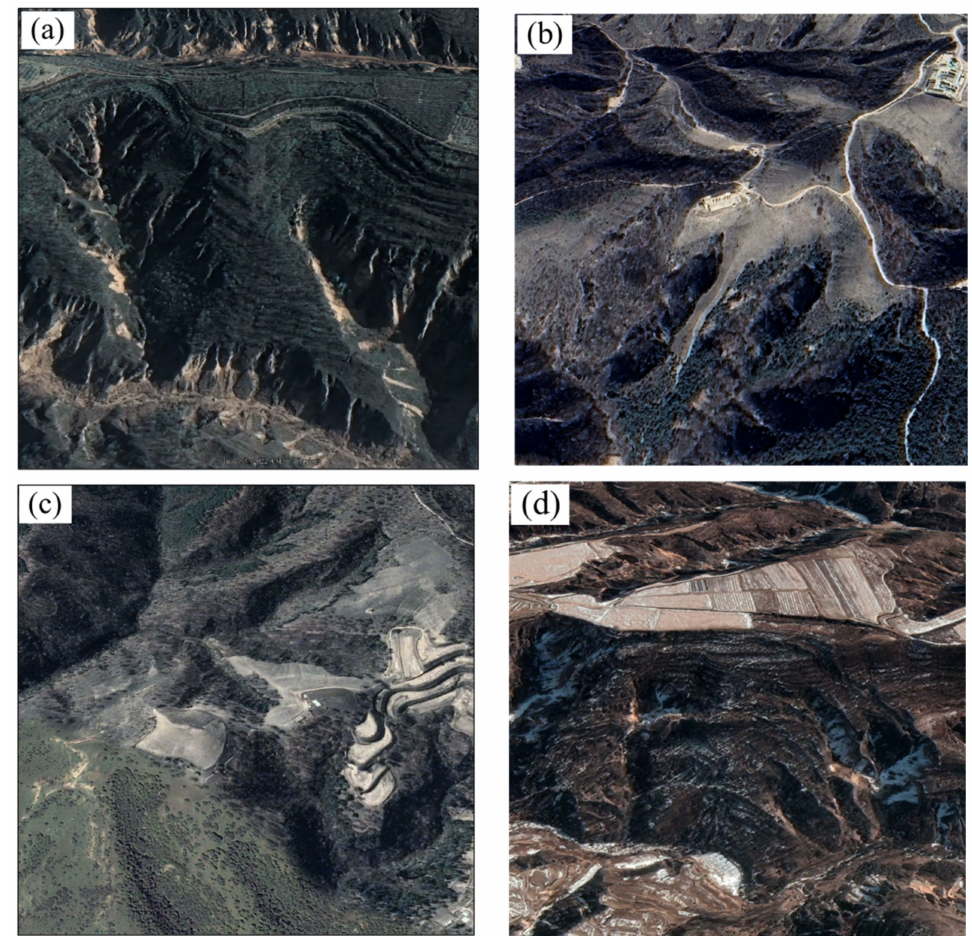
Figure 16. Examples of landforms in loess ridge and hill regions. ( a – d ) show the distribution of shoulder lines in loess ridge and hill regions,